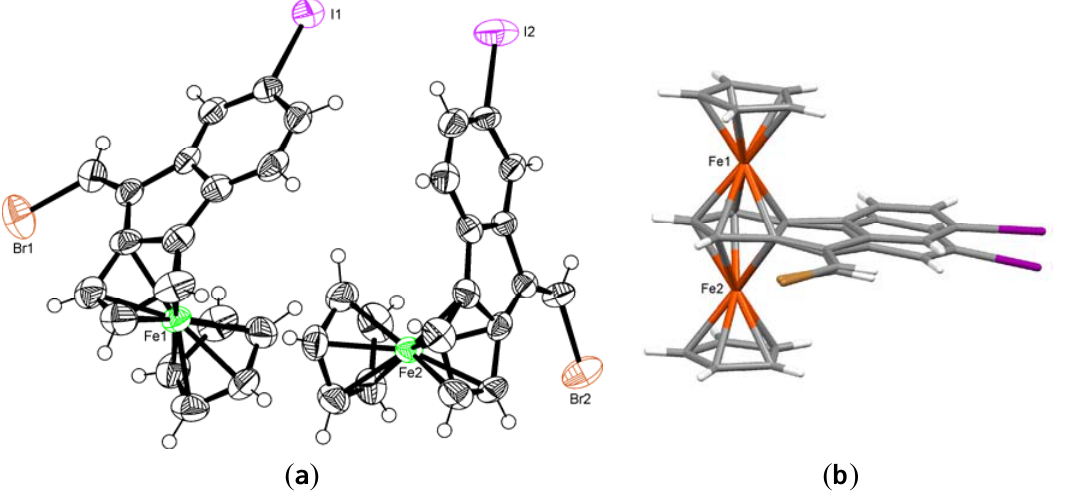
Figure 3. ( a ) Two independent molecules in the crystal structure of 7 ; ( b ) Overlay of the two enantiomers.